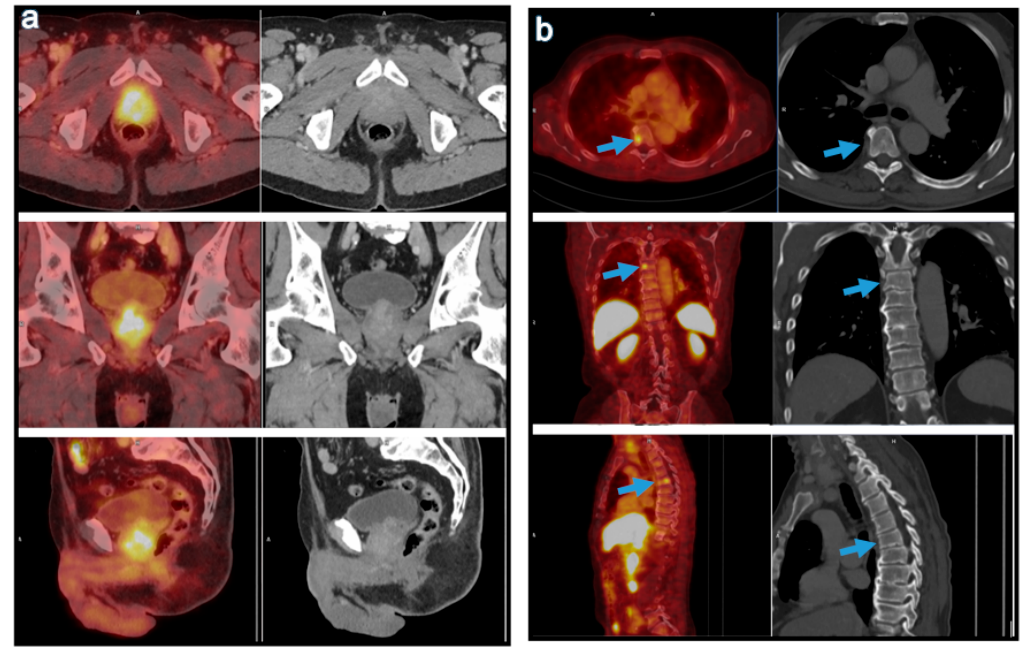
Figure 2. Primary staging of a treatment-naïve, 70-year-old patient with PCa metastasizing to the 5th and 9th thoracic vertebrae, using [ 18 F]-PSMA PET–CT. The PSA value at the time of examination was 7.8 µg/L. ( a ) The PSMA-positive primary tumor (SUVmax 6.4). ( b ) The PSMA-positive bone metastasis in T5 (SUVmax 3.7).